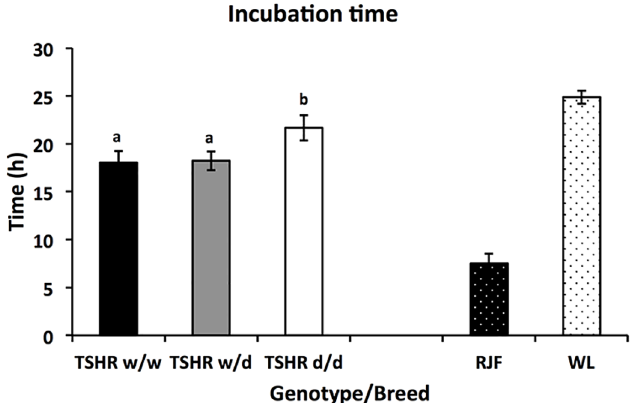
Fig 1. Estimated marginal means for incubation time ( ± SEM) from first hatch for each genotype/breed. TSHR genotypes: d/d: homozygous for the domestic allele, w/w: homozygous for the wild type allel, and w/d: heterozygous. RJF: Red Junglefowl, WL: White Leghorn. Post-hoc analyses TSHR : bars designated with different letters differ significantly at P < 0.05.